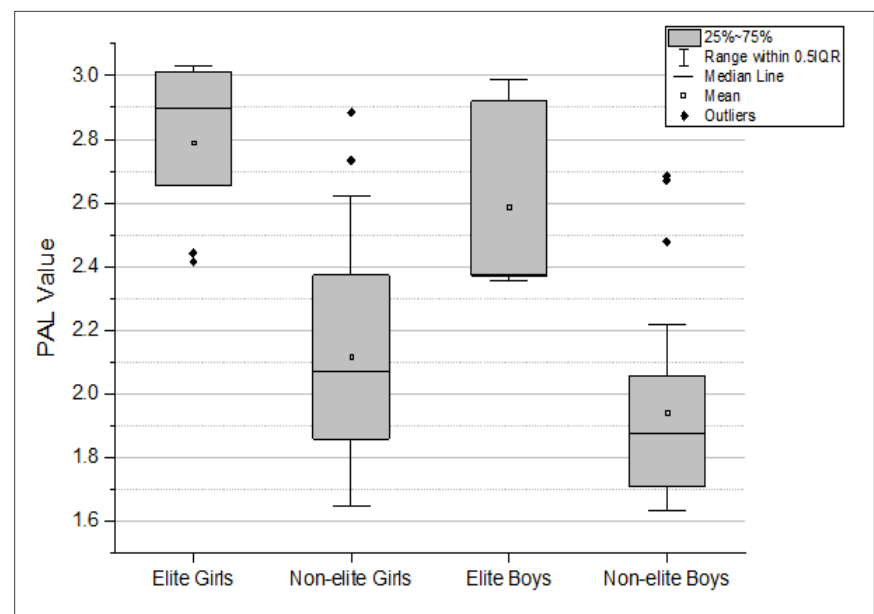
Figure 3. Physical activity contour of athletes . Figure legend: box plot lower/first quartile (Q1), median, upper/third quartile (Q3), and outlier of PAL values in elite and non ‐ elite athletes.